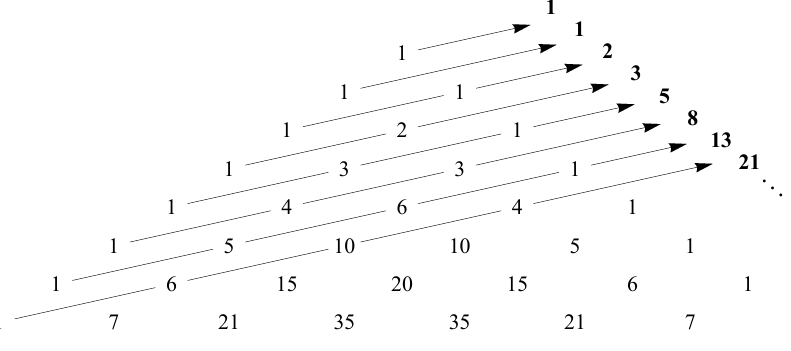
Figure 1. Pascal’s triangle with added north-east diagonals. Table 1. Pascal’s triangle with transformed north-east diagonals to the